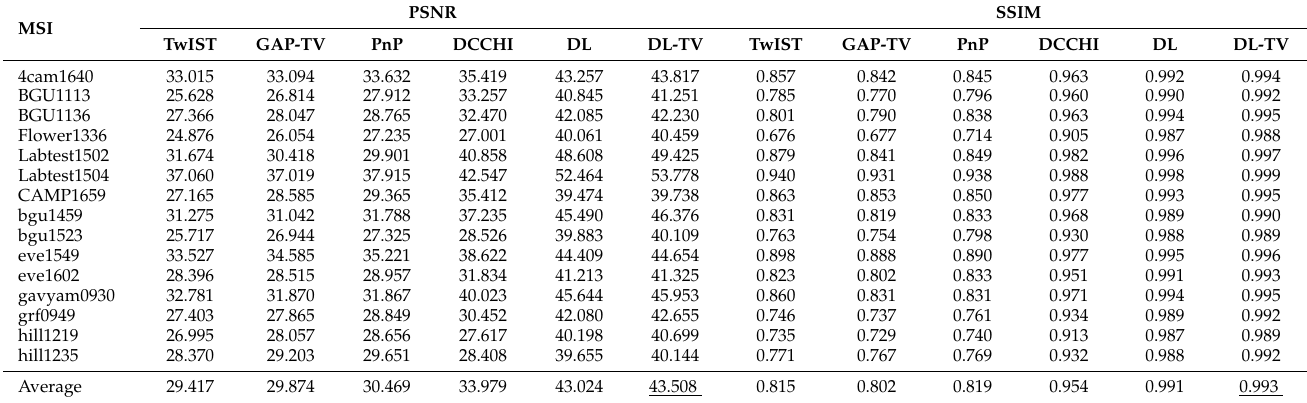
Table 3. Average PSNR and SSIM of the 15 reconstructed MSIs for the ICVL